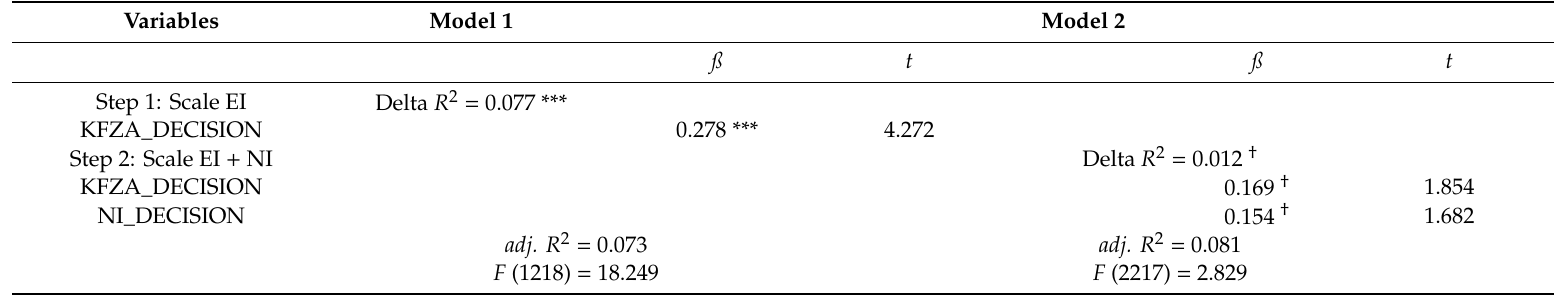
Table A7. Hierarchical regression analyses for the relation between well-being and scales from existing instruments (EI) and the new instrument (NI) assessing decision